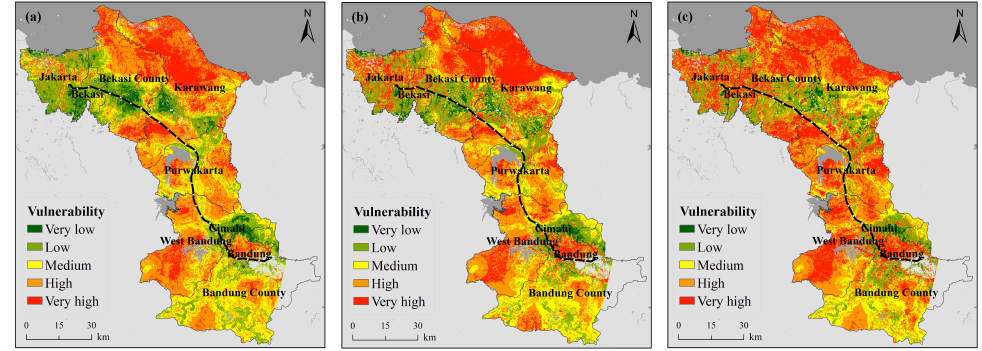
Figure 4. Spatiotemporal variation in the heat wave vulnerability (( a ) 2005, ( b ) 2014, ( c )